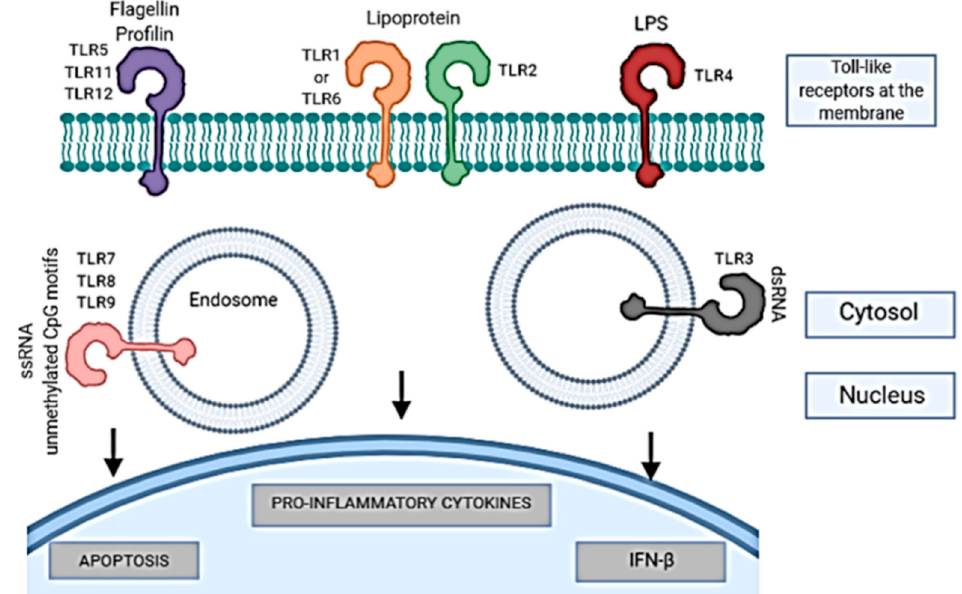
Figure 2. Toll-like receptors (TLRs) pathways that induce the inflammatory response mediated by cytokines (adapted from [278]). Created with Biorender.